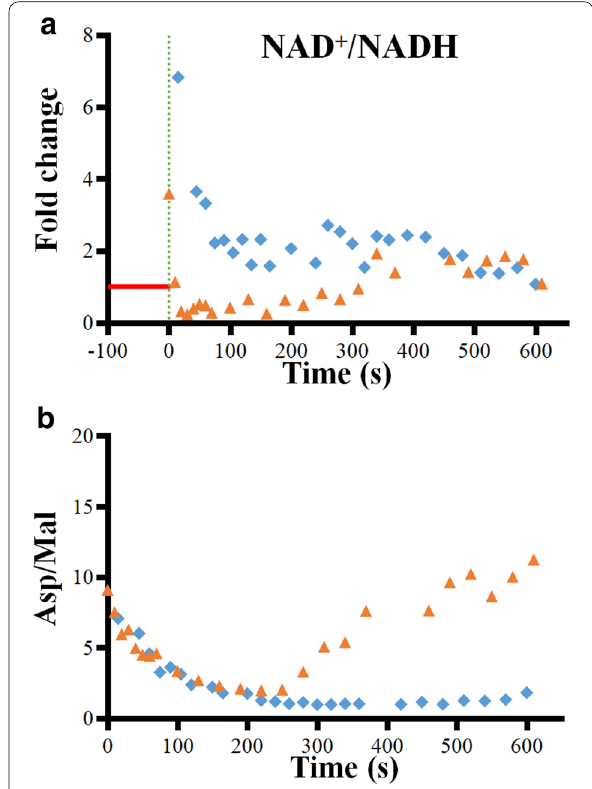
Fig. 9 a (NAD + /NADH) / ( NAD + 0 /NADH 0 ) ratio profiles after the glucose pulses; b Asp/Mal ratio’s in both glucose pulse experiments. Vertical hashed lines represent the start of the glucose pulse. The steady-state level is represented as red horizontal